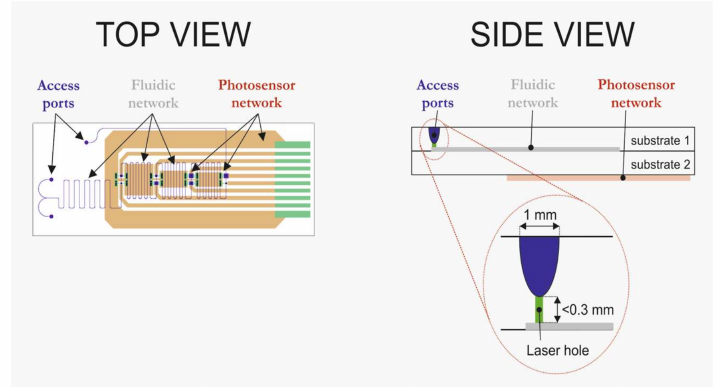
Figure 1. Schematic views of the design of the all-glass chip with integrated